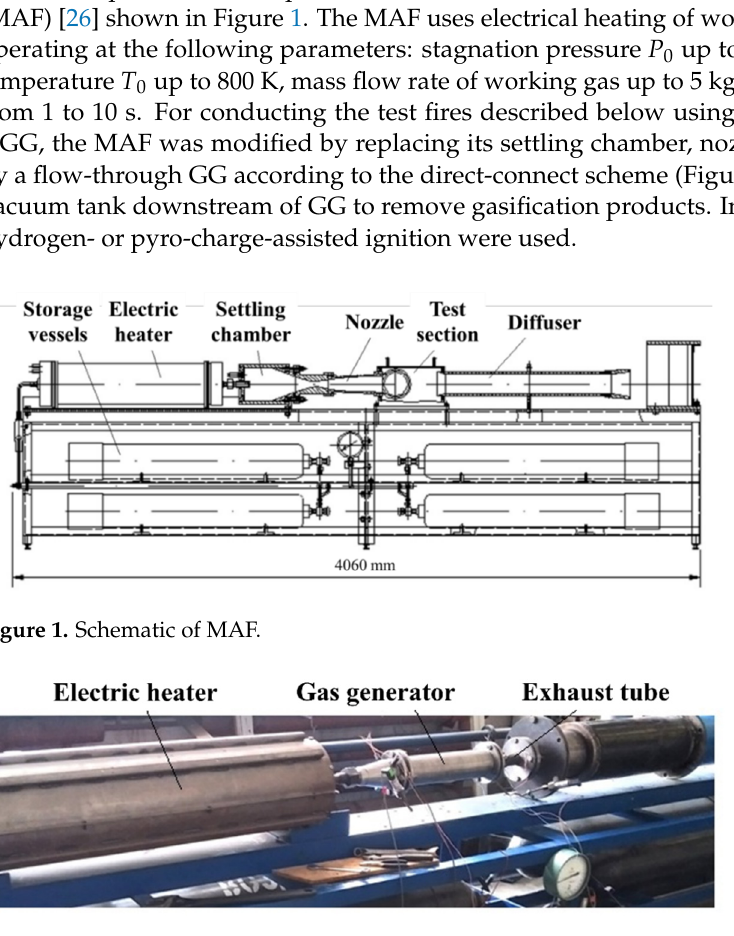
Figure 2. Direct-connect scheme of flow-through GG.